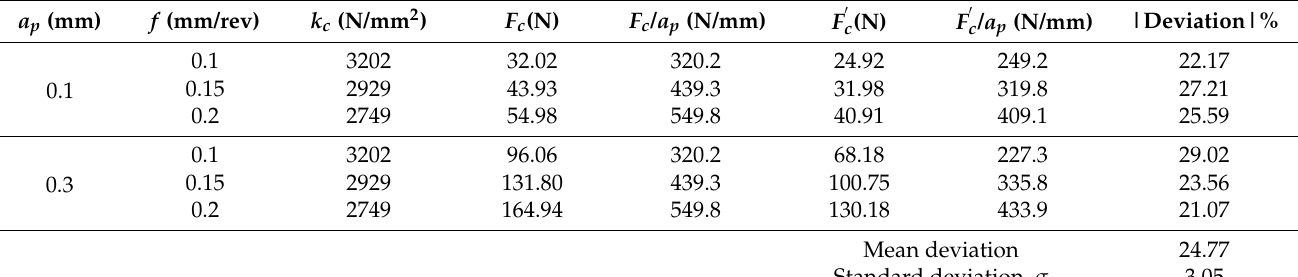
Table 7. The comparison of the readings of the smart tool holder with the theoretical values.